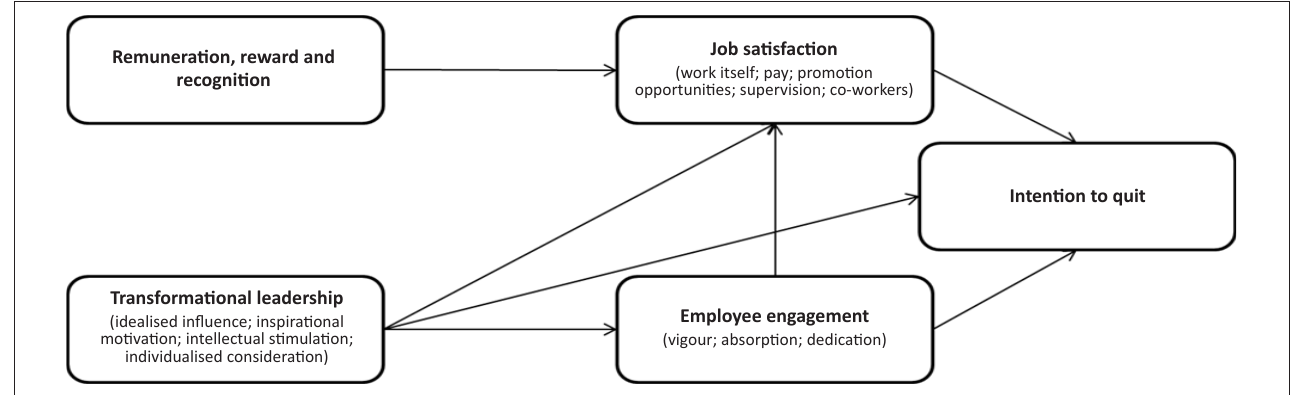
FIGURE 1: Partial theoretical model of antecedents of intention to